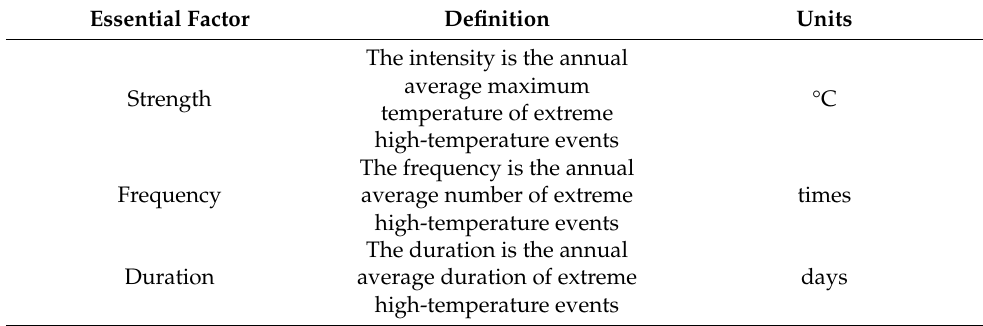
Table 1. Definition of intensity, frequency, and duration of extreme high-temperature